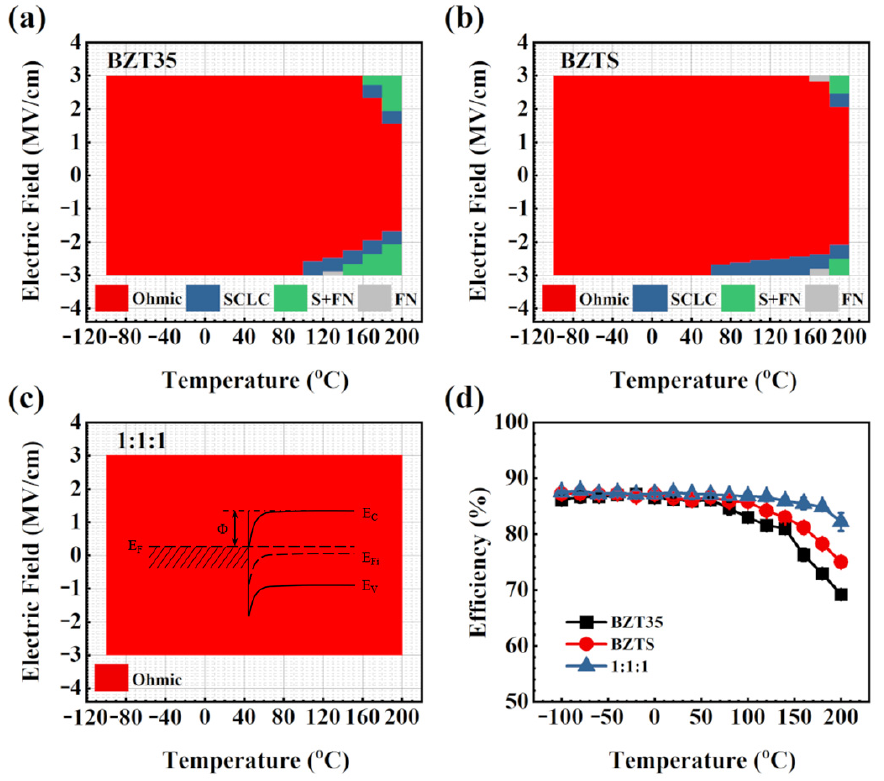
Figure 4. An overview of the leakage mechanisms for BZT35 ( a ), BZTS ( b ) and BZT35/BZTS/BZT35(1:1:1) ( c ) films at positive and negative bias under the temperature from − 120 ◦ C to 200 ◦ C, insert is the energy band diagram of ohmic conduction. ( d ) The energy storage efficiency of them under the temperature from − 120 ◦ C to 200 ◦